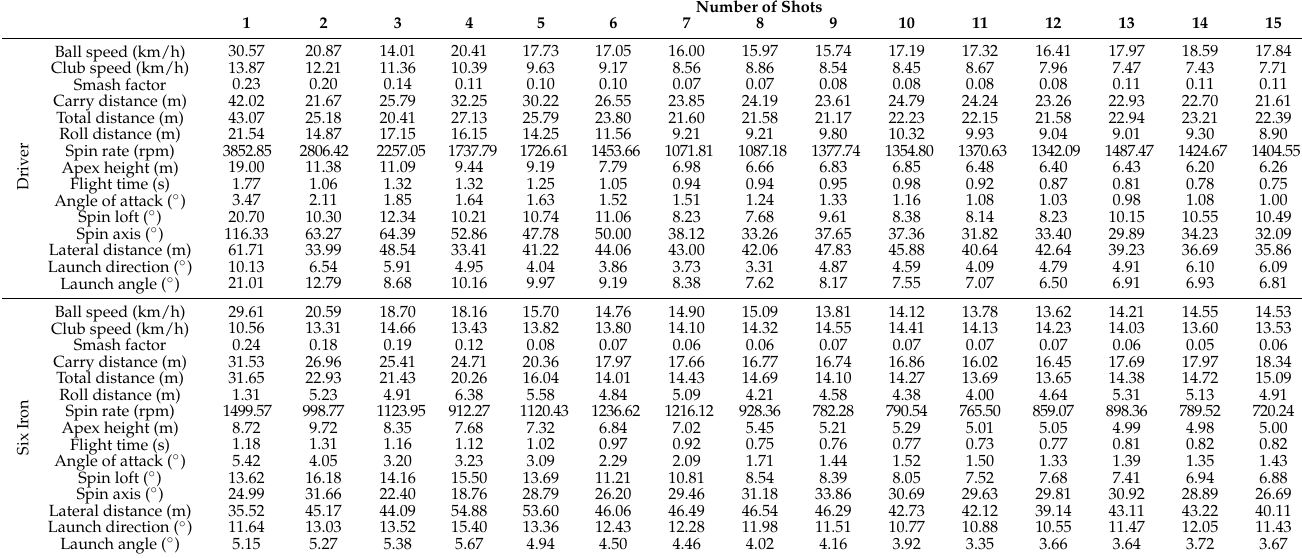
Table 2. Minimum detectable change for FlightScope Mevo+ extracted